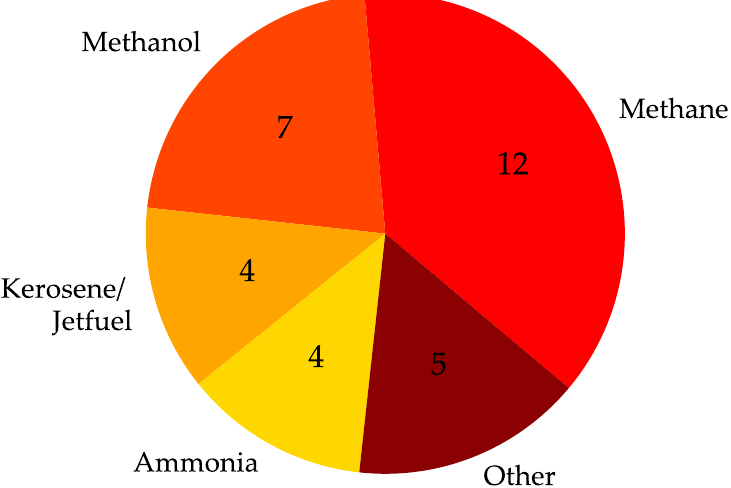
Figure 11. Number of projects per type of electrofuel produced other than hydrogen.